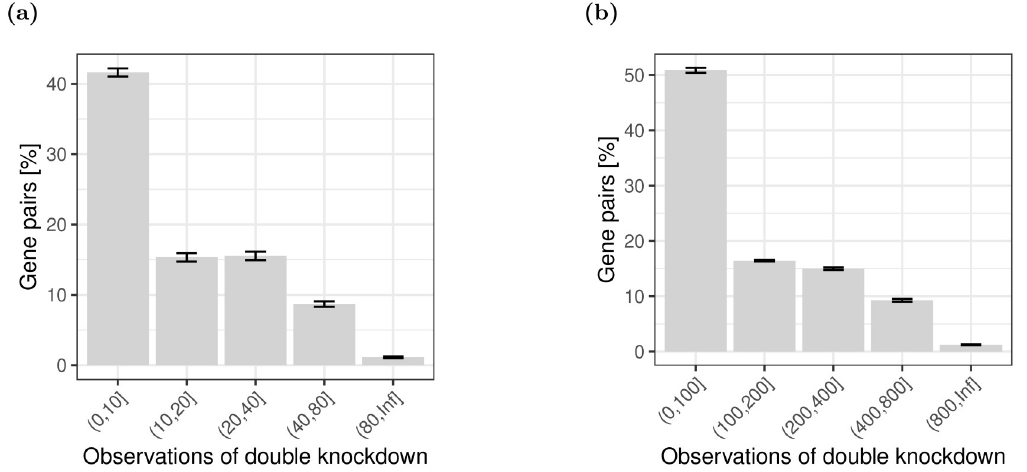
Fig 4. The distribution of the fraction of gene pairs stratified by ranges of observed double knockdowns. Gene pairs with zero observations are not shown. (a) p = 100, n = 1000; (b) p = 1000, n = 10000.